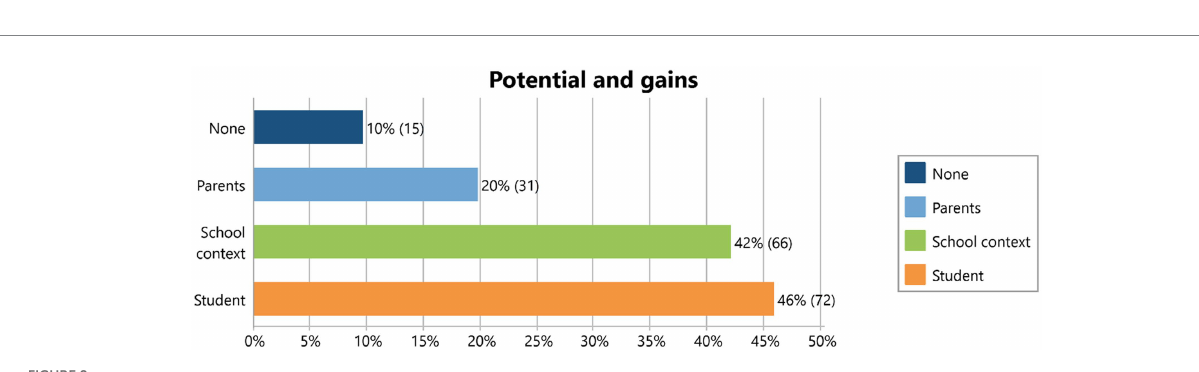
FIGURE 8 Frequency of documents referring to each subcategory within Potential and